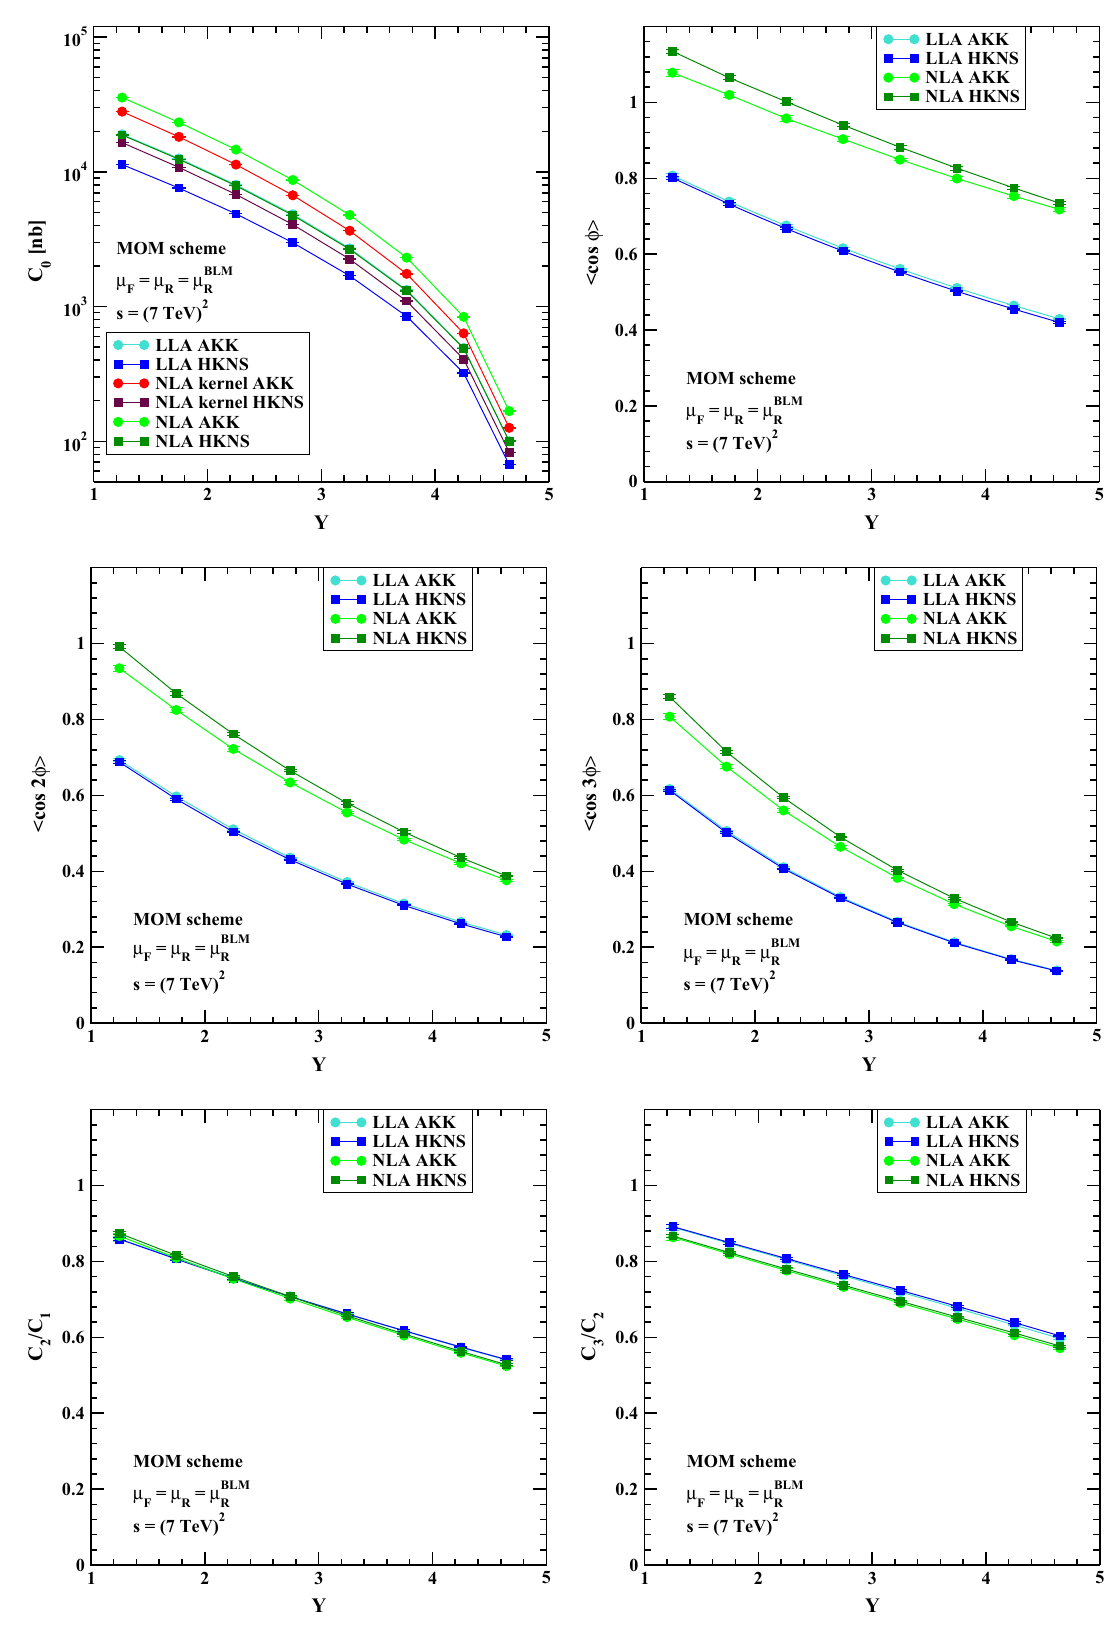
√ s = 7 TeV, and Y ≤ 4 . , R